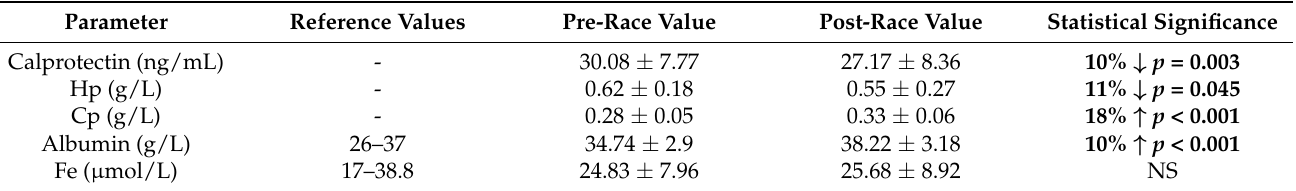
Table 1. Values of serum acute phase biomarkers in 23 horses before and after the endurance